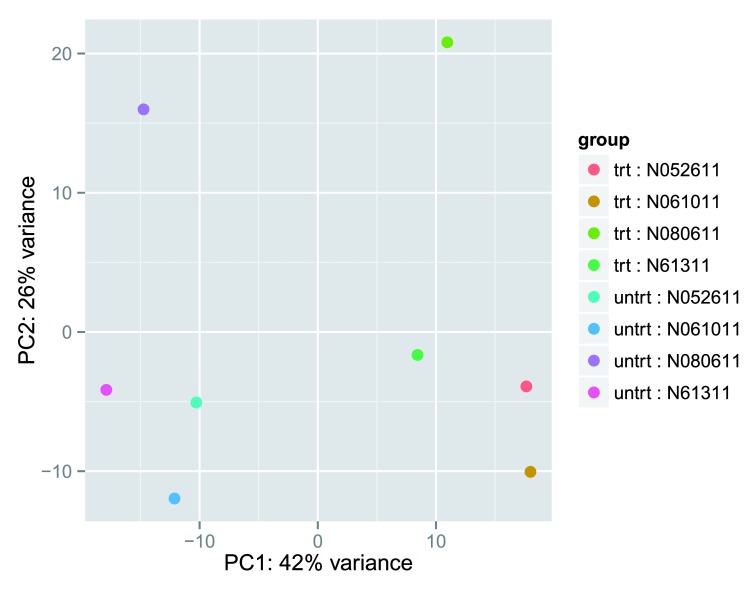
PCA plot using the rlog-transformed values.Each unique combination of treatment and cell line is given its own color.